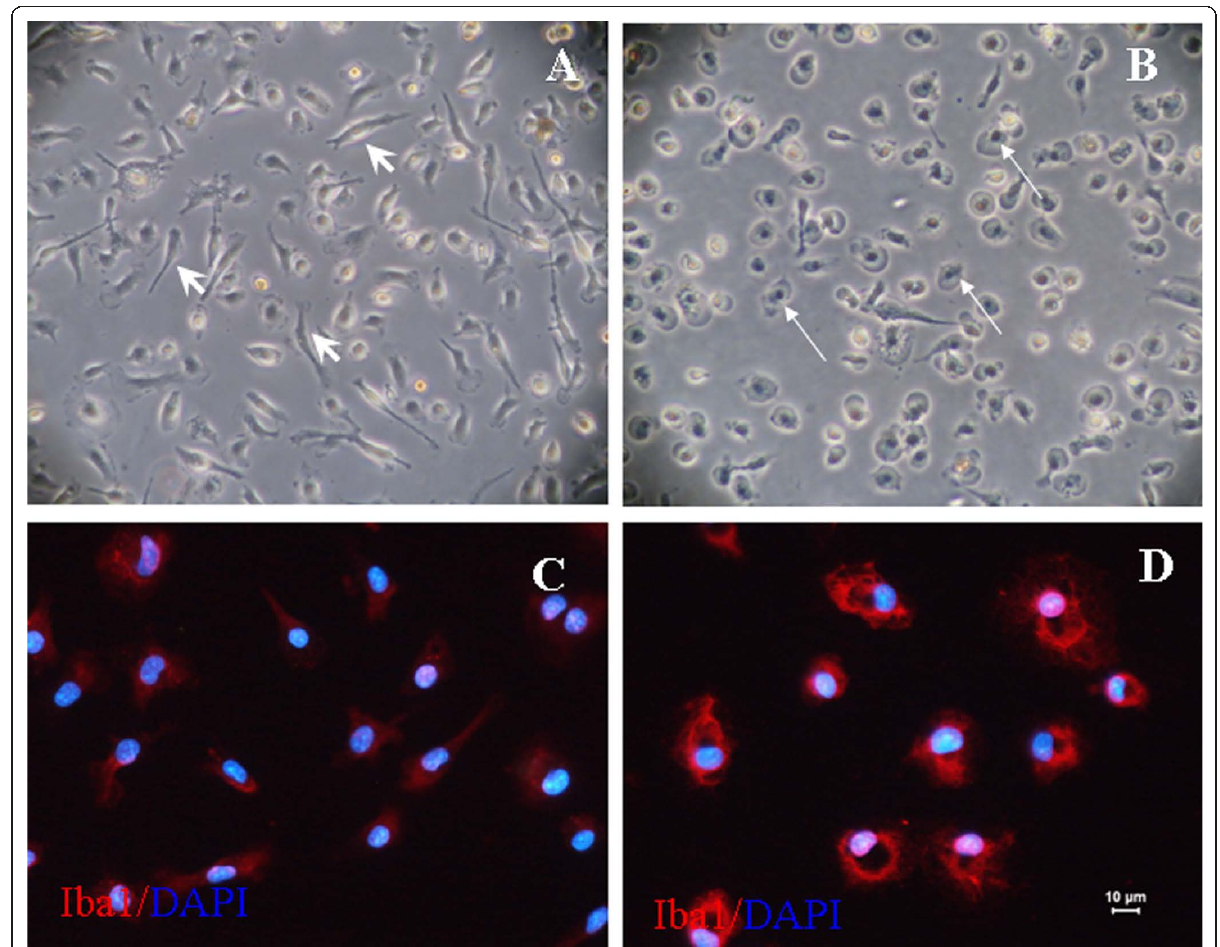
Figure 2 Effect of glycated albumin (GA) on cultured retinal microglial cells . (A) Phase-contrast image of purified retinal microglial cells after 72 h. The cells have a ramified shape, with a single long process and a small cell body (short arrow). (B) Following exposure to 250 μ g/mL GA for 24 h, the cells became rounder, larger, and amoeboid in shape (long arrow) (original magnification: × 100). (C) Microglial cells without GA exposure show weak Iba1 immunofluorescence (red) in the cytoplasm. (D) Following exposure to 250 μ g/mL GA for 24 h, Iba1 expression was up-regulated, and the protein was translocated to membrane ruffles. The nuclei of the microglia are labeled with DAPI